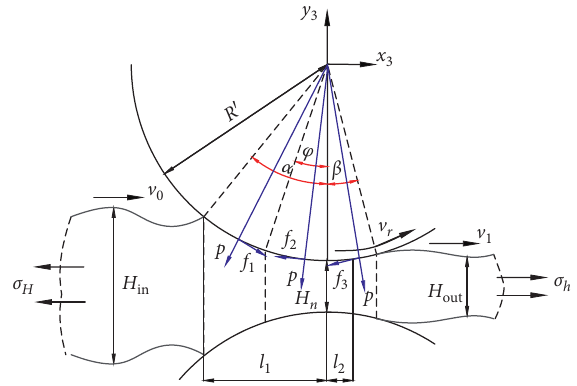
Figure 1: Vibration geometry model of the roll